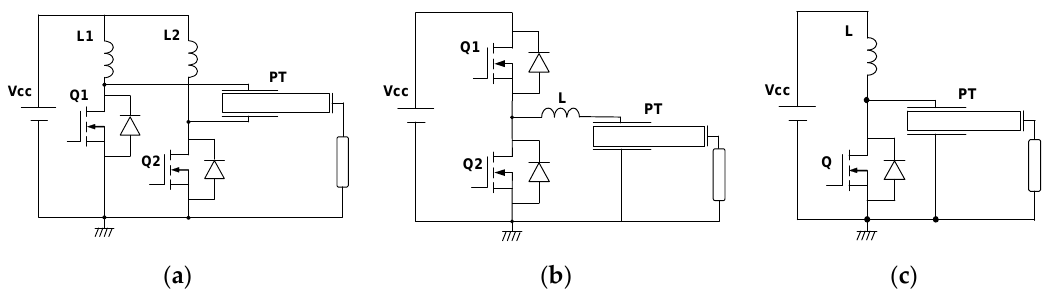
Figure 10. Commonly used piezoelectric transformer circuit topologies: ( a ) push-pull; ( b ) half-bridge; ( c ) Cass-E.